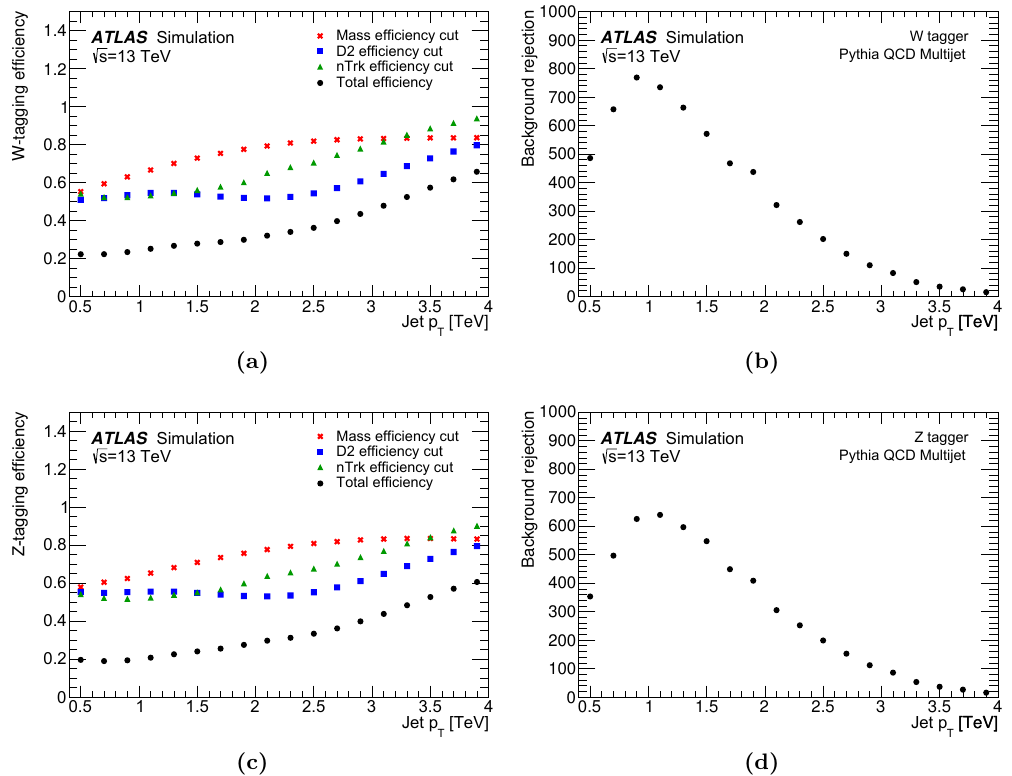
Figure 3 . The (a) per-boson signal e(cid:14)ciency for the jet mass, D as the combined e(cid:14)ciency and (b) background rejection (1 = e(cid:14)ciency) of the W tagger for HVT W 0 ! WZ ! qqqq and MC simulated multijets as a function of the jet p for the Z tagger are shown in (c) and